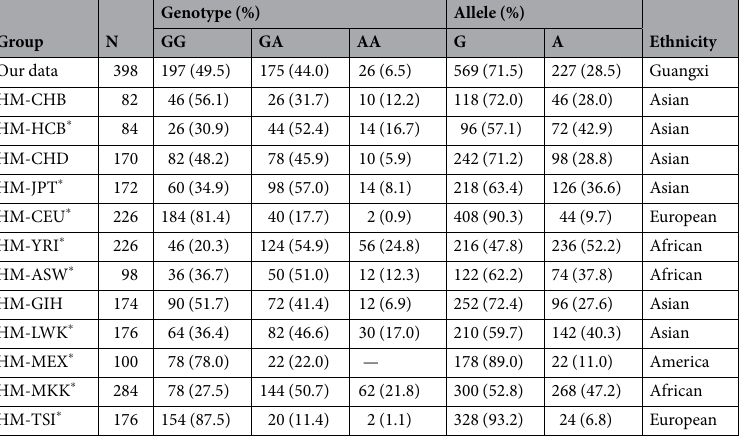
Table 3. Distribution of the rs9722 polymorphism in different populations. * P < 0.05 comparing with our present data; HM: Haplotype Map; CHB: Han Chinese in Beijing, China; HCB: Han Chinese in Beijing, China; CHD: Chinese in Metropolitan Denver, Colorado; JPT: Japanese in Tokyo, Japan; CEU: Utah residents with northern and western European ancestry; YRI: Yoruba in Ibadan, Nigeria; ASW: African ancestry in Southwest USA; GIH: Gujarati Indians in Houston, Texas; LWK: Luhya in Webuye, Kenya; MEX: Mexican ancestry in Los Angeles, California; MKK: Maasai in Kinyawa, Kenya; TSI: Toscans in Italy.